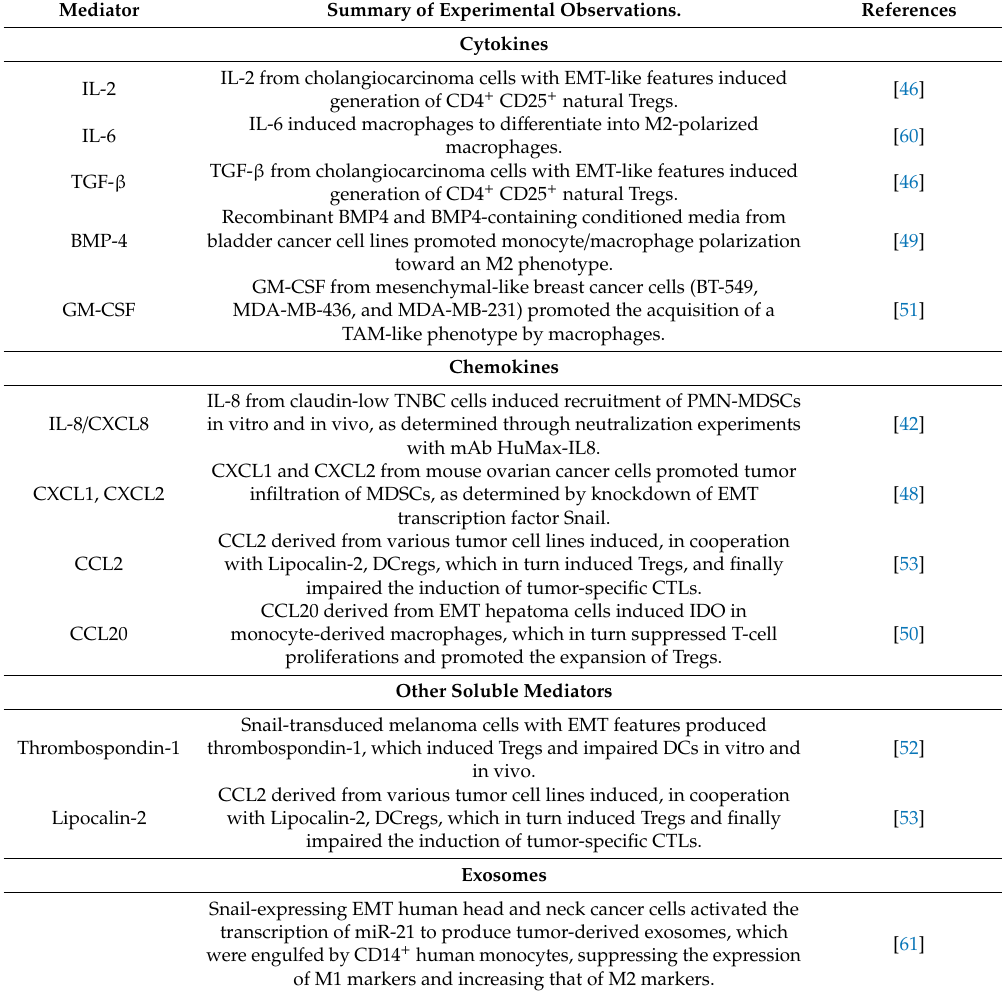
Table 2. Mediators (soluble mediators or exosomes) of the e ff ects of EMT tumor cells on cells of the immune system. Summary of Experimental